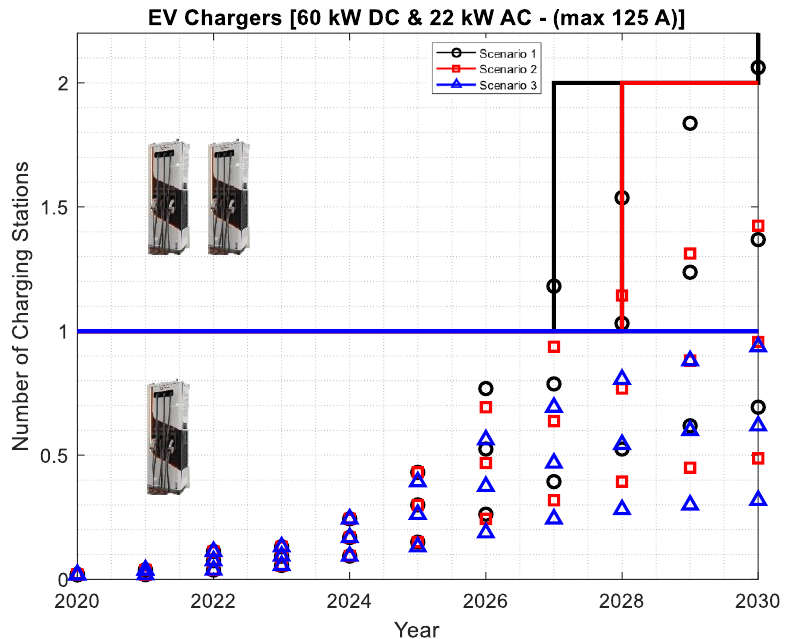
Figure 20. Power demand scenarios.